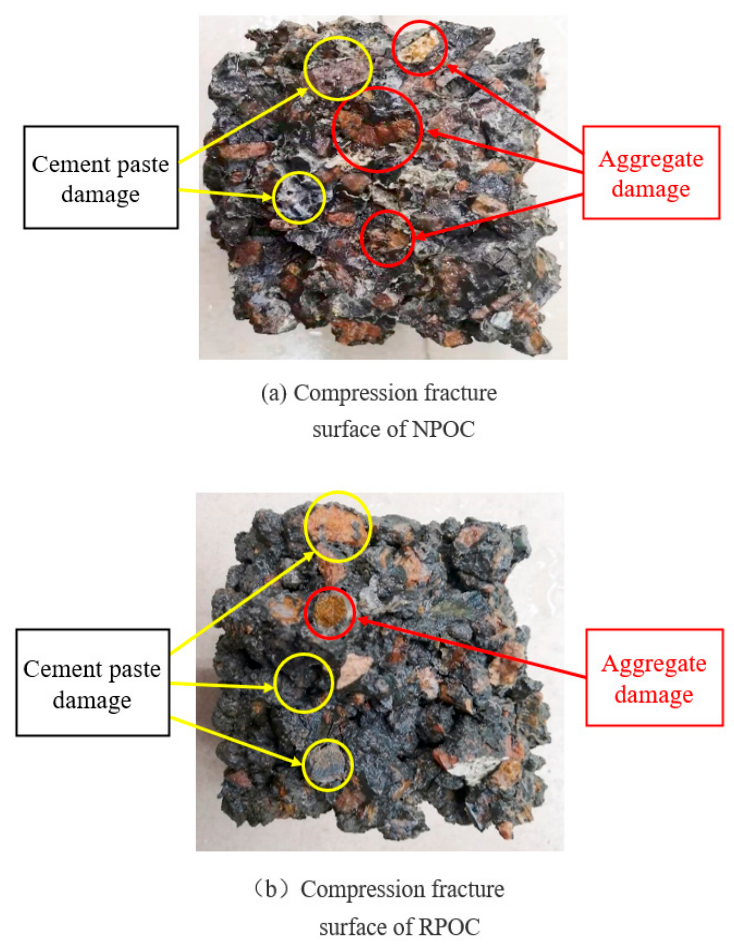
Figure 13. Compression fracture surface of porous concrete.